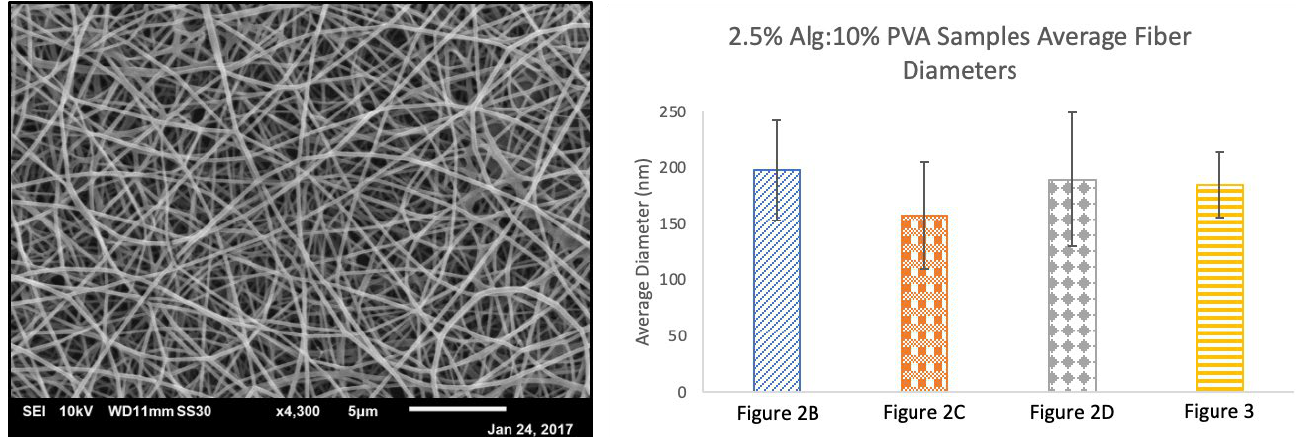
Figure 3. Left: SEM micrograph of Alg–PVA nanofibers. 3:7 2.5% Alg:10% PVA at 7.5 μL/min, 30 kV, 100 mm, and 2.5 mL disp. Right: Comparison of average Alg/PVA fiber diameters, n = 40. Each label corresponds to the referenced fiber formulation and spinning conditions described for the micrograph image of the fibers. All fibers formed spun at a rate of 7.5 μL/min, with a target distance of 100 mm: Figure 2B 7:3 2.5% Alg:10% PVA at 25 kV; Figure 2C 1:1 2.5% Alg:10% PVA at 30 kV; Figure 2D 2:8 2.5% Alg:10% PVA at 25 kV; Figure 3 3:7 2.5% Alg:10% PVA at 30 kV.